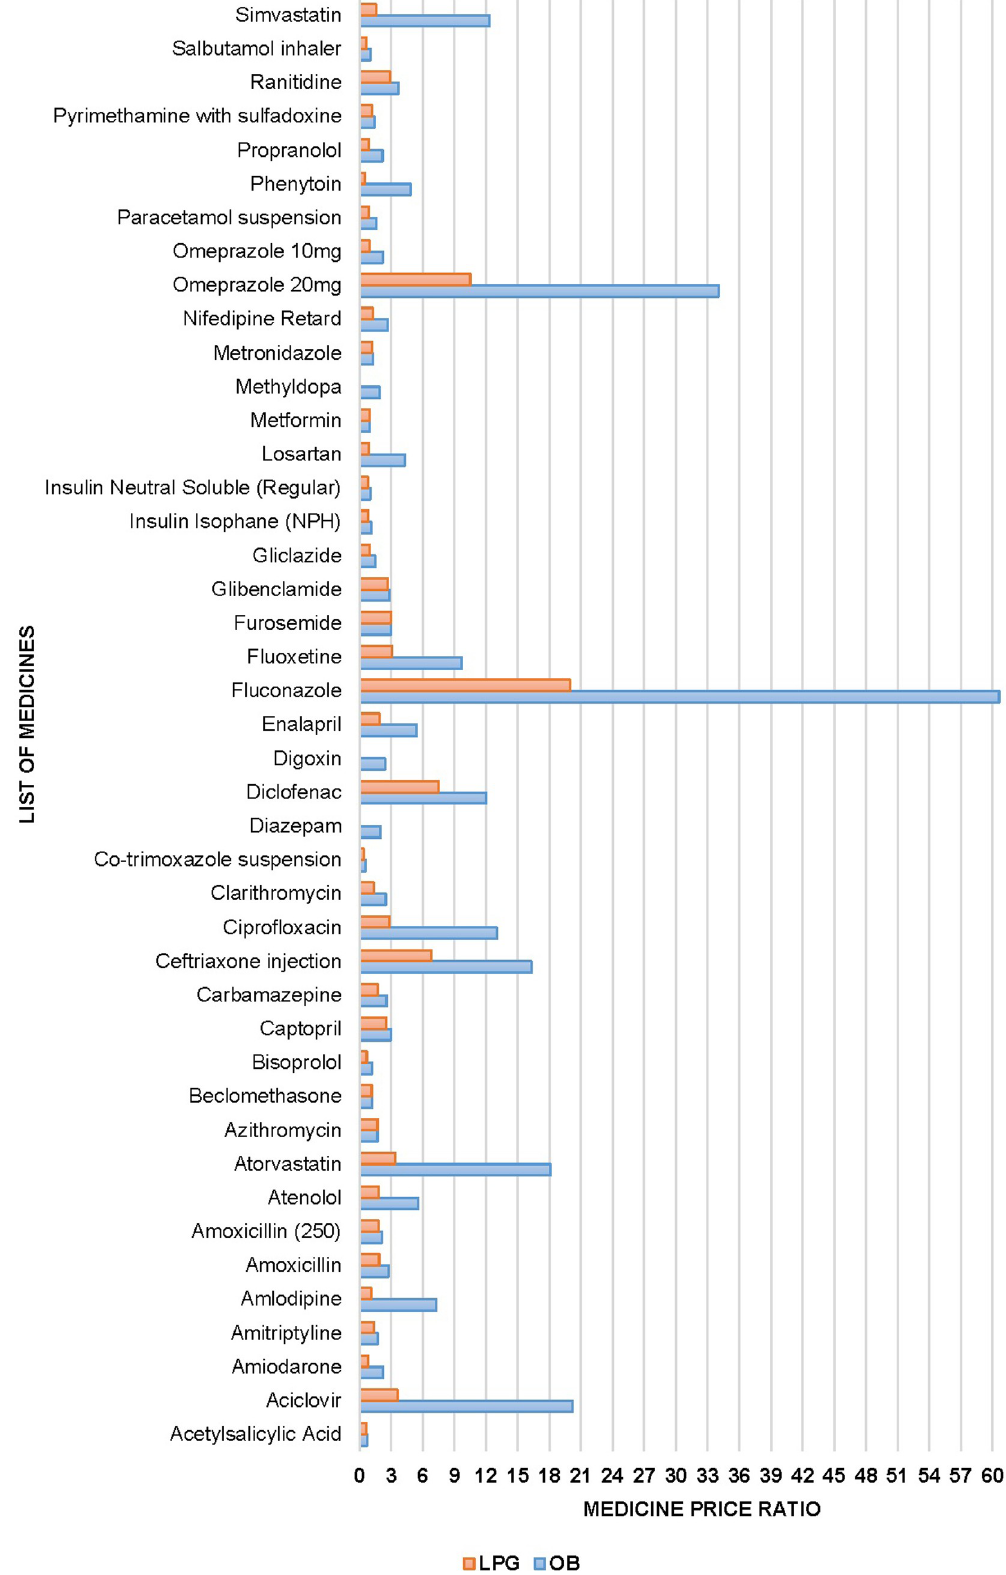
Fig 2. Individual medicine price ratios for surveyed medicines in private sector.